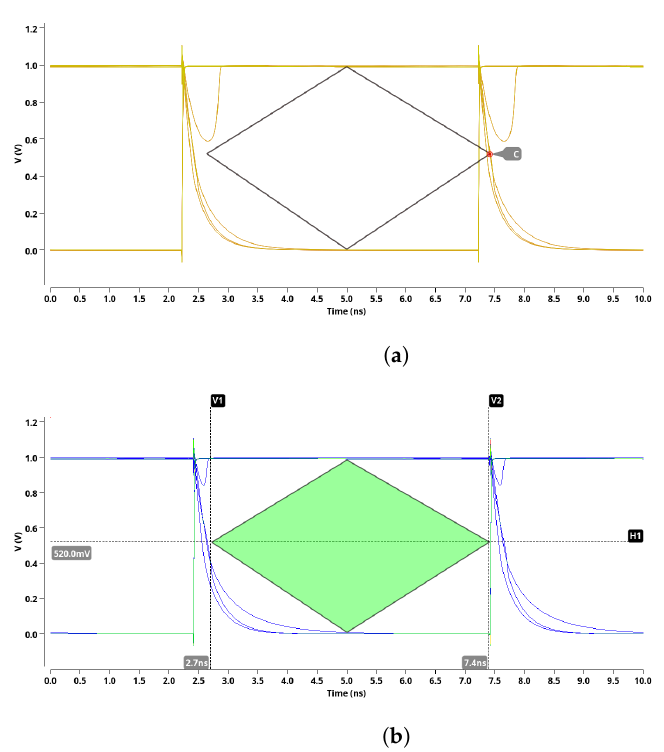
Figure 7. ( a ) Eye mask designed for Case 1 failed when NON = 1. ( b ) Optimized eye diagram to counter the effect of PV and the thermal effect.